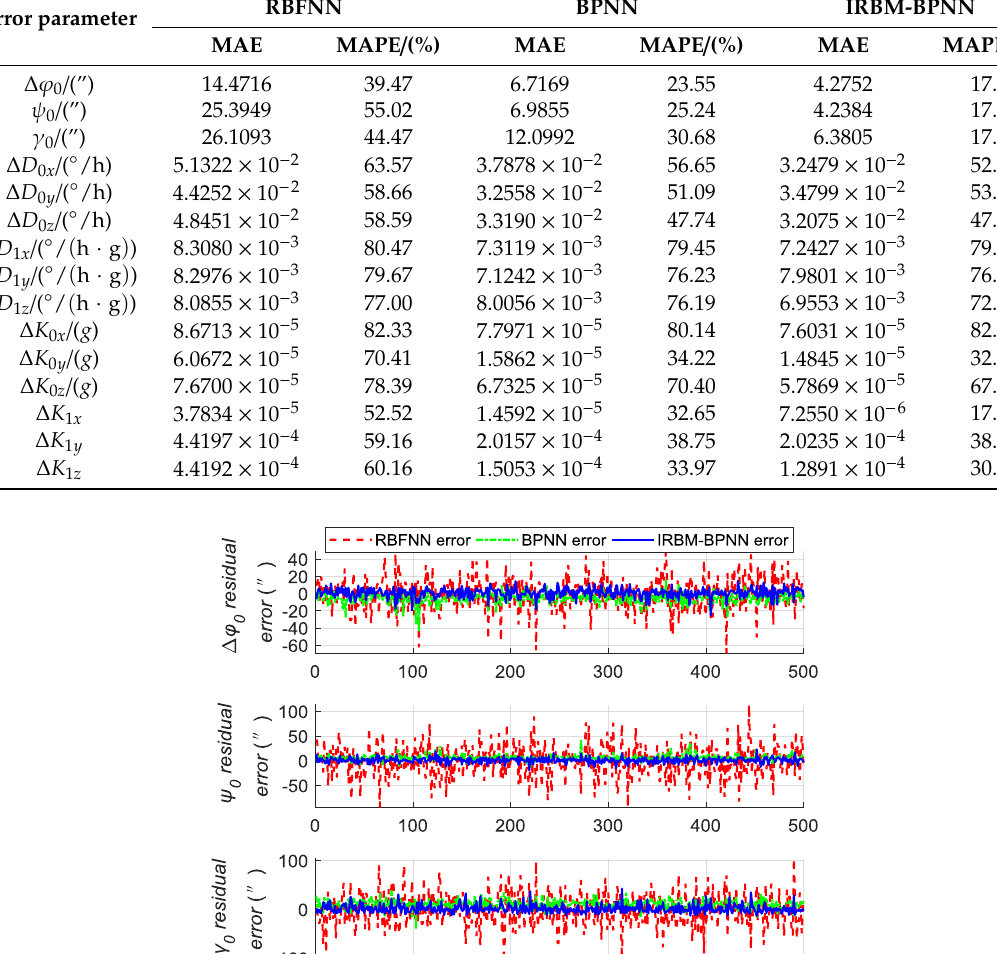
Table 4. Statistical results of error parameter forecast values of testing samples.